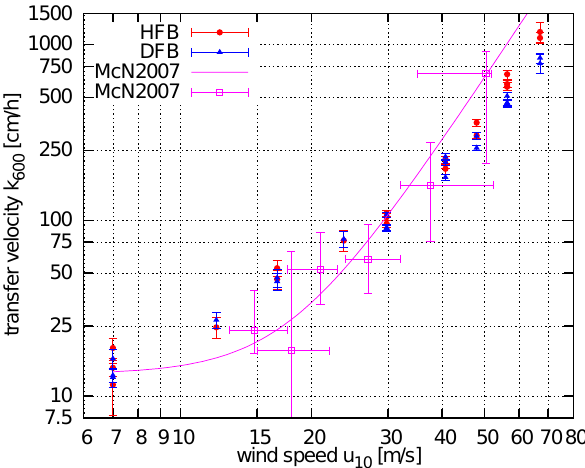
Fig. 4. Measured transfer velocities k meas for HFB and DFB as well as the transfer velocities k pred predicted by Eq. (2) in a double log- arithmic plot.